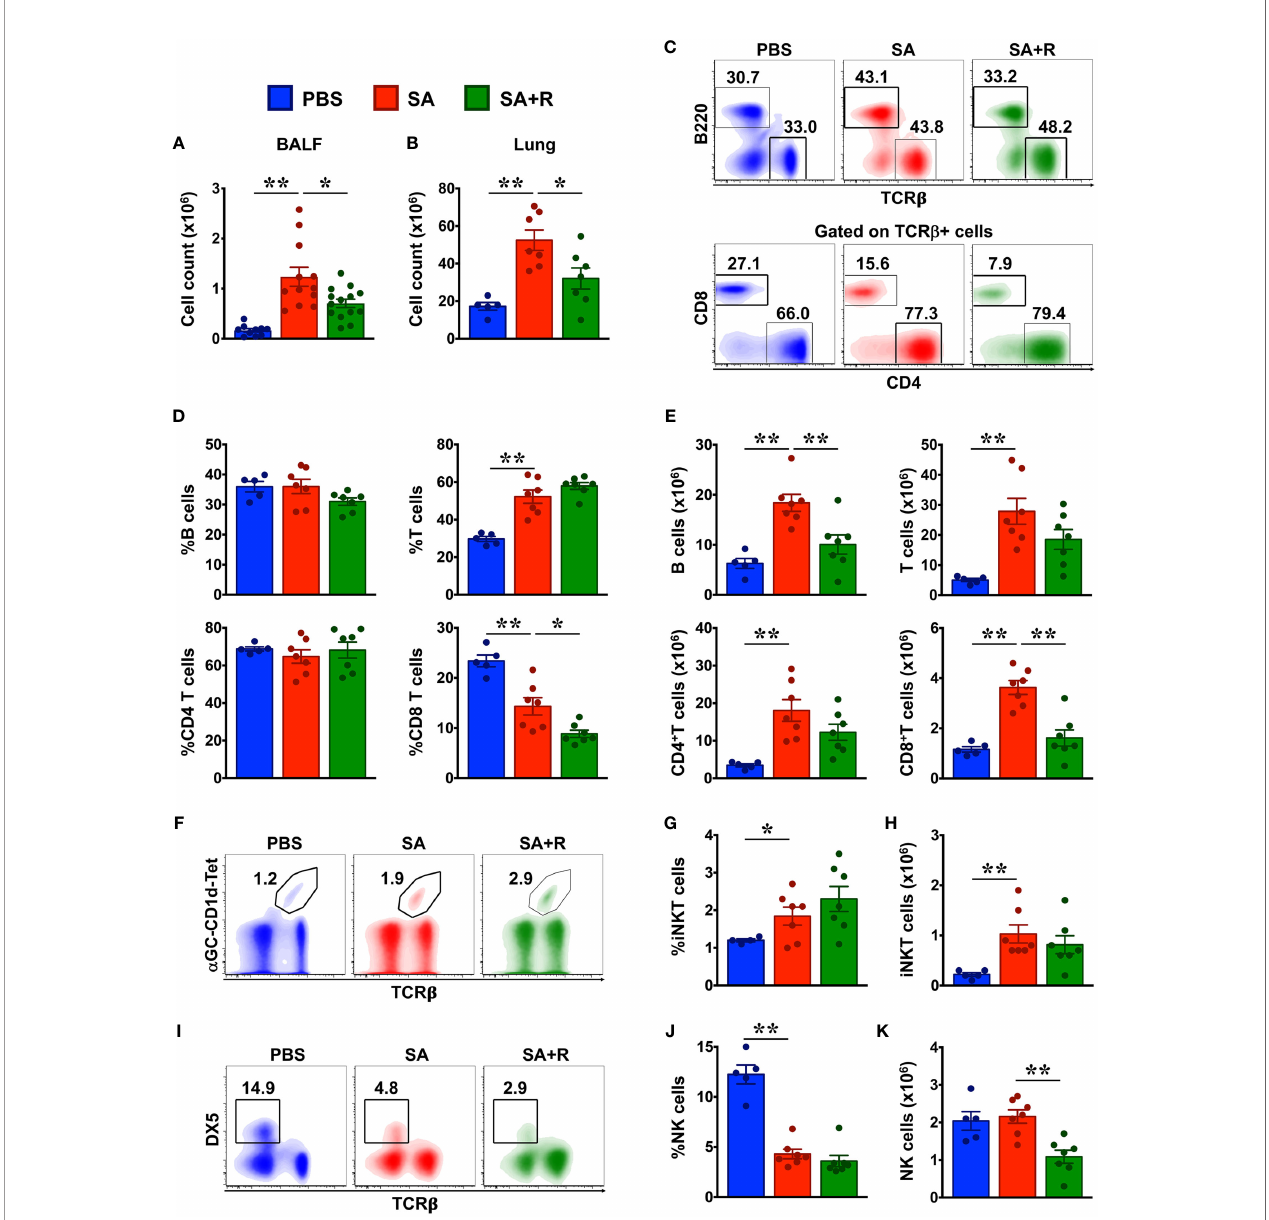
FIGURE 3 | Reduced cellular in fi ltration in the BALF and lungs of SA mice treated with Ruxolitinib. (A, B) BALF (A) and lung tissues (B) from control (PBS-injected), SA and SA mice treated with Ruxolitinib (SA+R) were analyzed for total leukocyte counts. Data is shown as mean ± SEM and pooled from 3 independent experiments with a total of 5-13 (BALF) or 5-7 (lungs) mice per cohort. (C – K) Lung immune cells were analyzed for various lymphocytic populations by fl ow cytometry. Representative density plots (C, F, I) are from 2 independent experiments. Average frequency (D, G, J) and total cell numbers (E, H, K) of various lymphocytes from PBS, SA and SA+R mice were pooled. Data is presented as the mean of each group ± SEM of at least 5-7 mice per group. Statistical signi fi cance was determined using Student ’ s unpaired t test with Welch ’ s correction. *p < 0.05, **p <